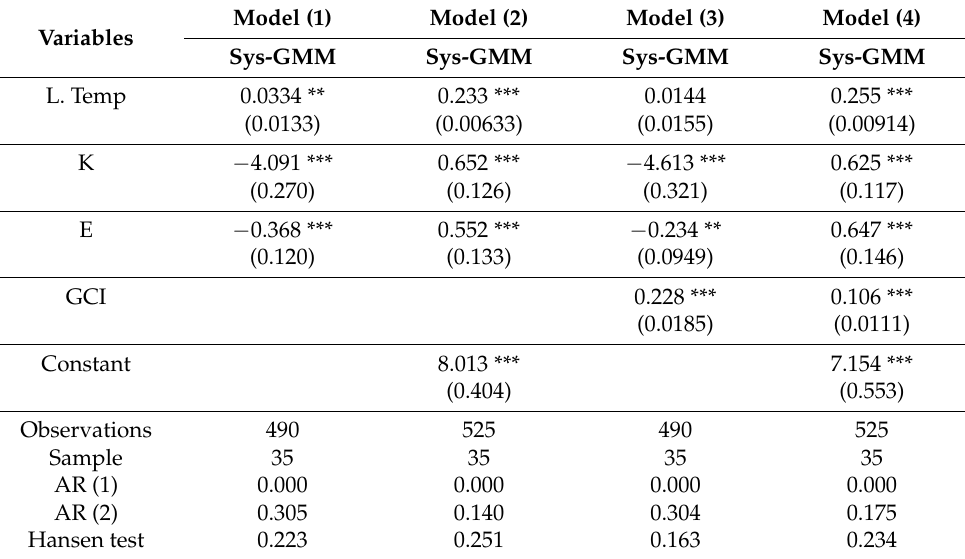
Table 3. The climate change function (OECD).